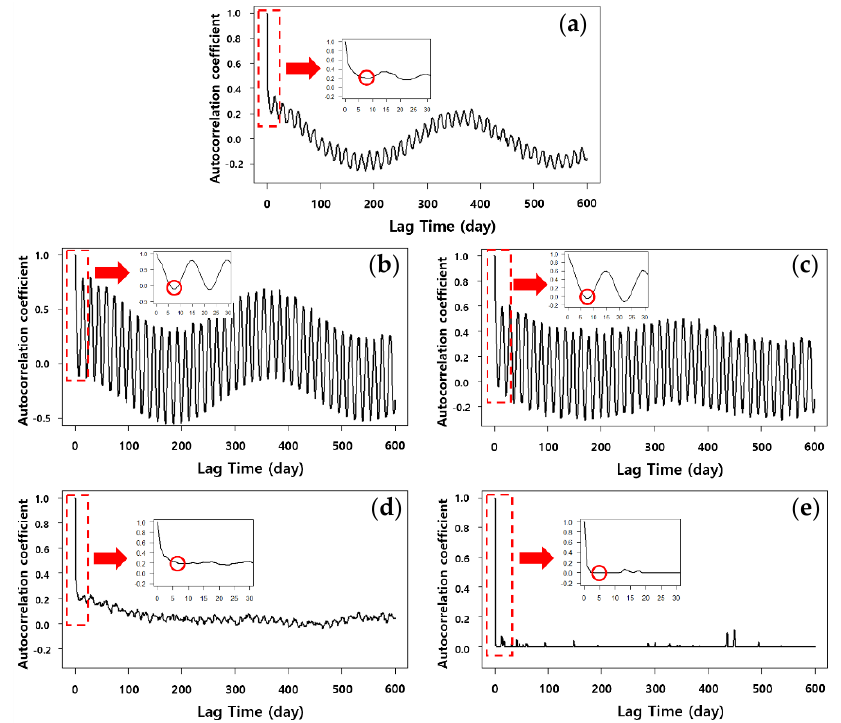
Figure 5. Autocorrelation function for each component: ( a ) water level, ( b ) tide component, ( c ) wave component, ( d ) noise component, ( e ) rainfall-runoff component.